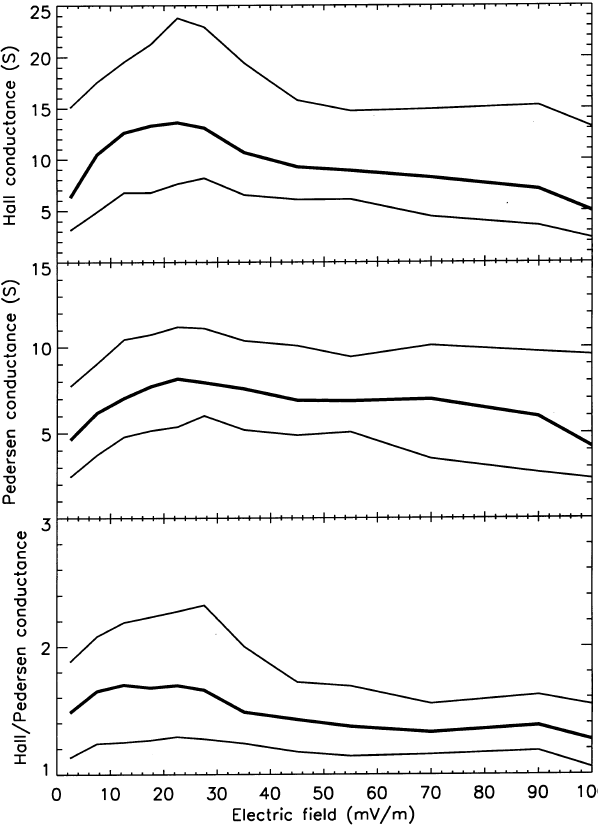
Fig. 4. Variation of the Hall conductance ( upper panel ), Pedersen conductance ( middle panel ) and the ratio of the Hall and Pedersen conductances ( lower panel ) with electric field magnitude. Solid lines indicate the median and upper and lower quartiles of the conductiv- ities and their ratio, binned with respect to the electric field with a bin width of 5 mV m ) 1 for fields less than 30 mV m ) 1 , 10 mV m ) 1 for fields between 30 and 60 mV m ) 1 and 20 mV m ) 1 for fields exceeding 60 mV m ) 1 . The figure includes only observations taken under conditions of solar zenith angle exceeding 105